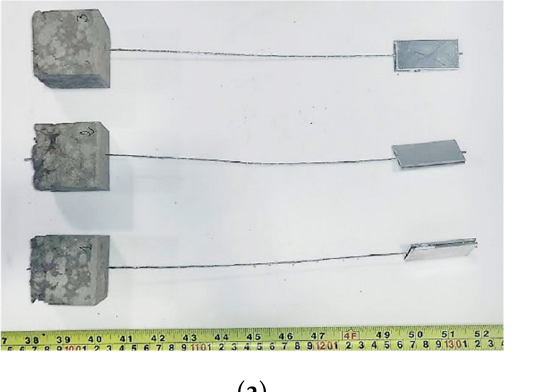
Figure 4. Presence of voids in ‘HW-GLT’ specimens as a result of the low workability of the cementi- tious mortar. ( a ) top view and ( b ) details of the mortar cubes.